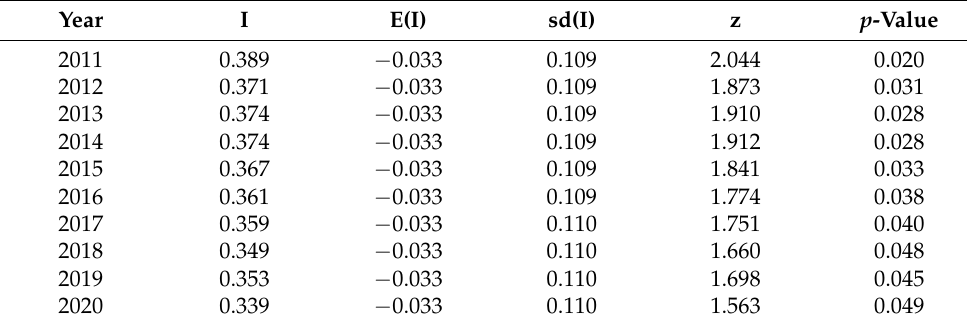
Table 4. Moran’s I of China’s Agricultural